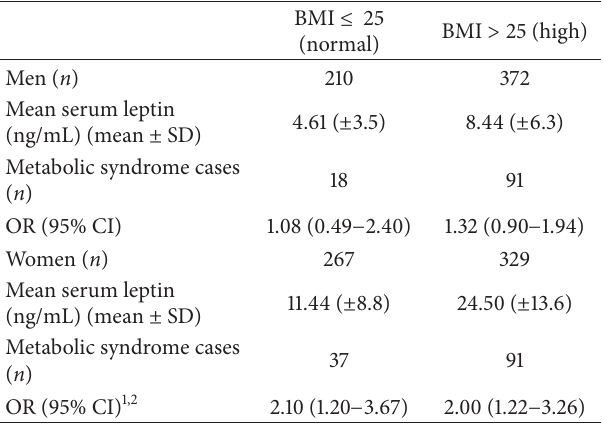
Table 5: Adjusted odd ratios (OR) of metabolic syndrome by BMI category.